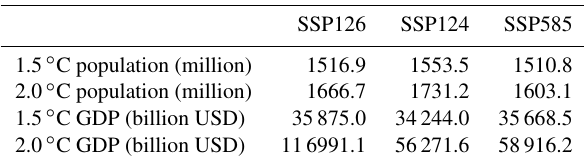
Table 3. Global population and GDP in the 1.5 and 2.0 ◦ C warming